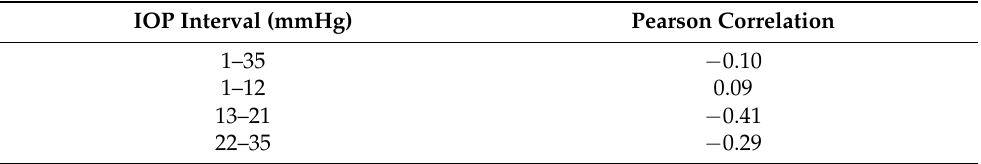
Table 5. Pearson correlation indexes between delta-pressure and corneal stiffness, E , for different pressure ranges.